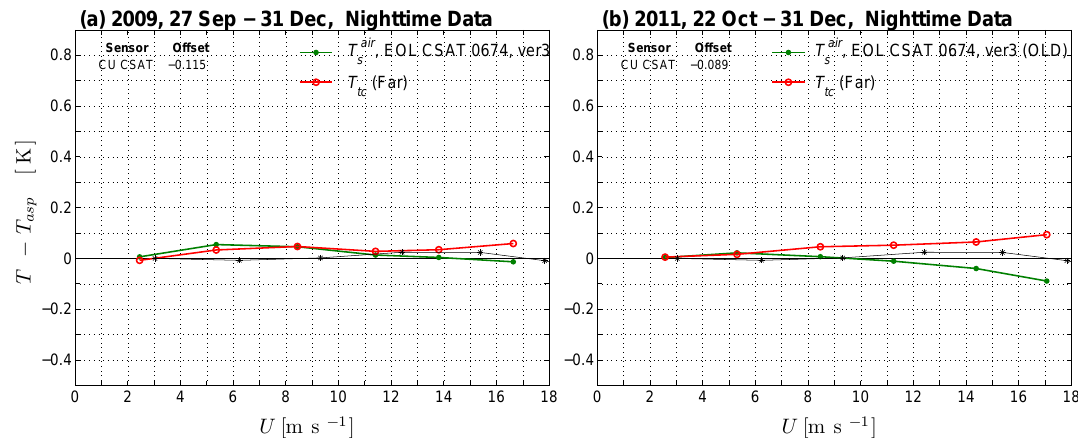
Fig. 9. As in Fig. 8, for the EOL CSAT 0674 ver3 using (a) newer and (b) older set of factory calibration coefficients. For details about the factory calibration dates, see Table 1. Daytime data are not